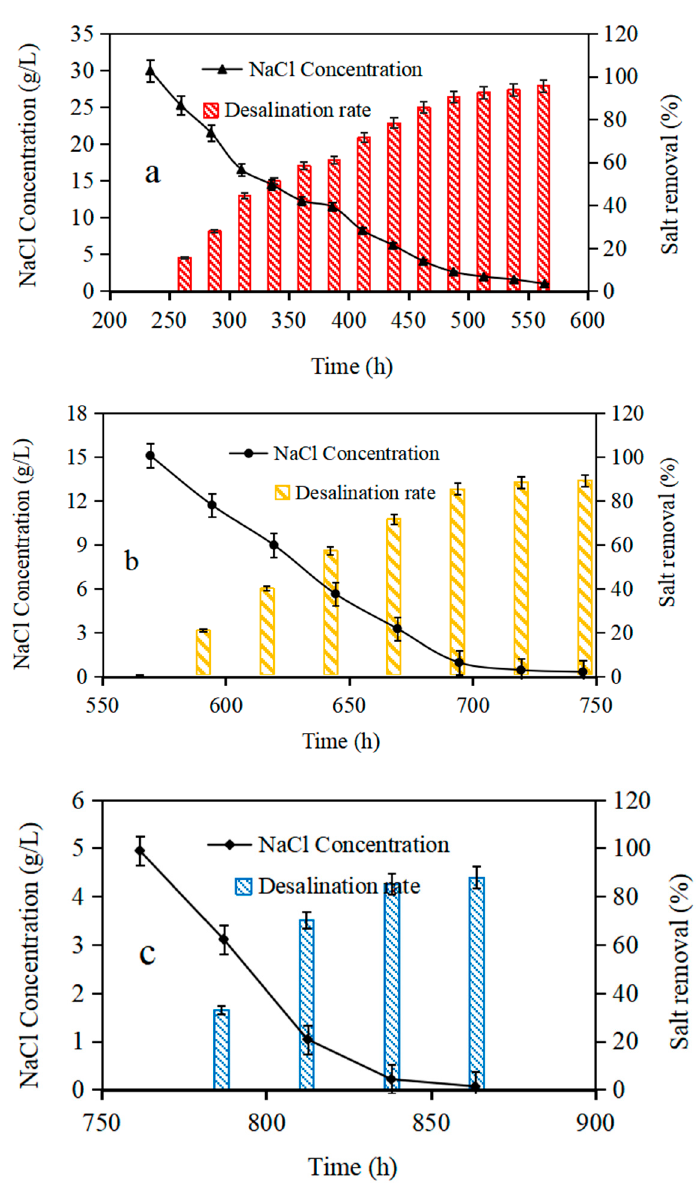
Figure 4. Change in NaCl concentration and salt removal of the AMDC (( a ) 30 g / L, ( b ) 15 g / L, ( c ) 5 g / L salinity).